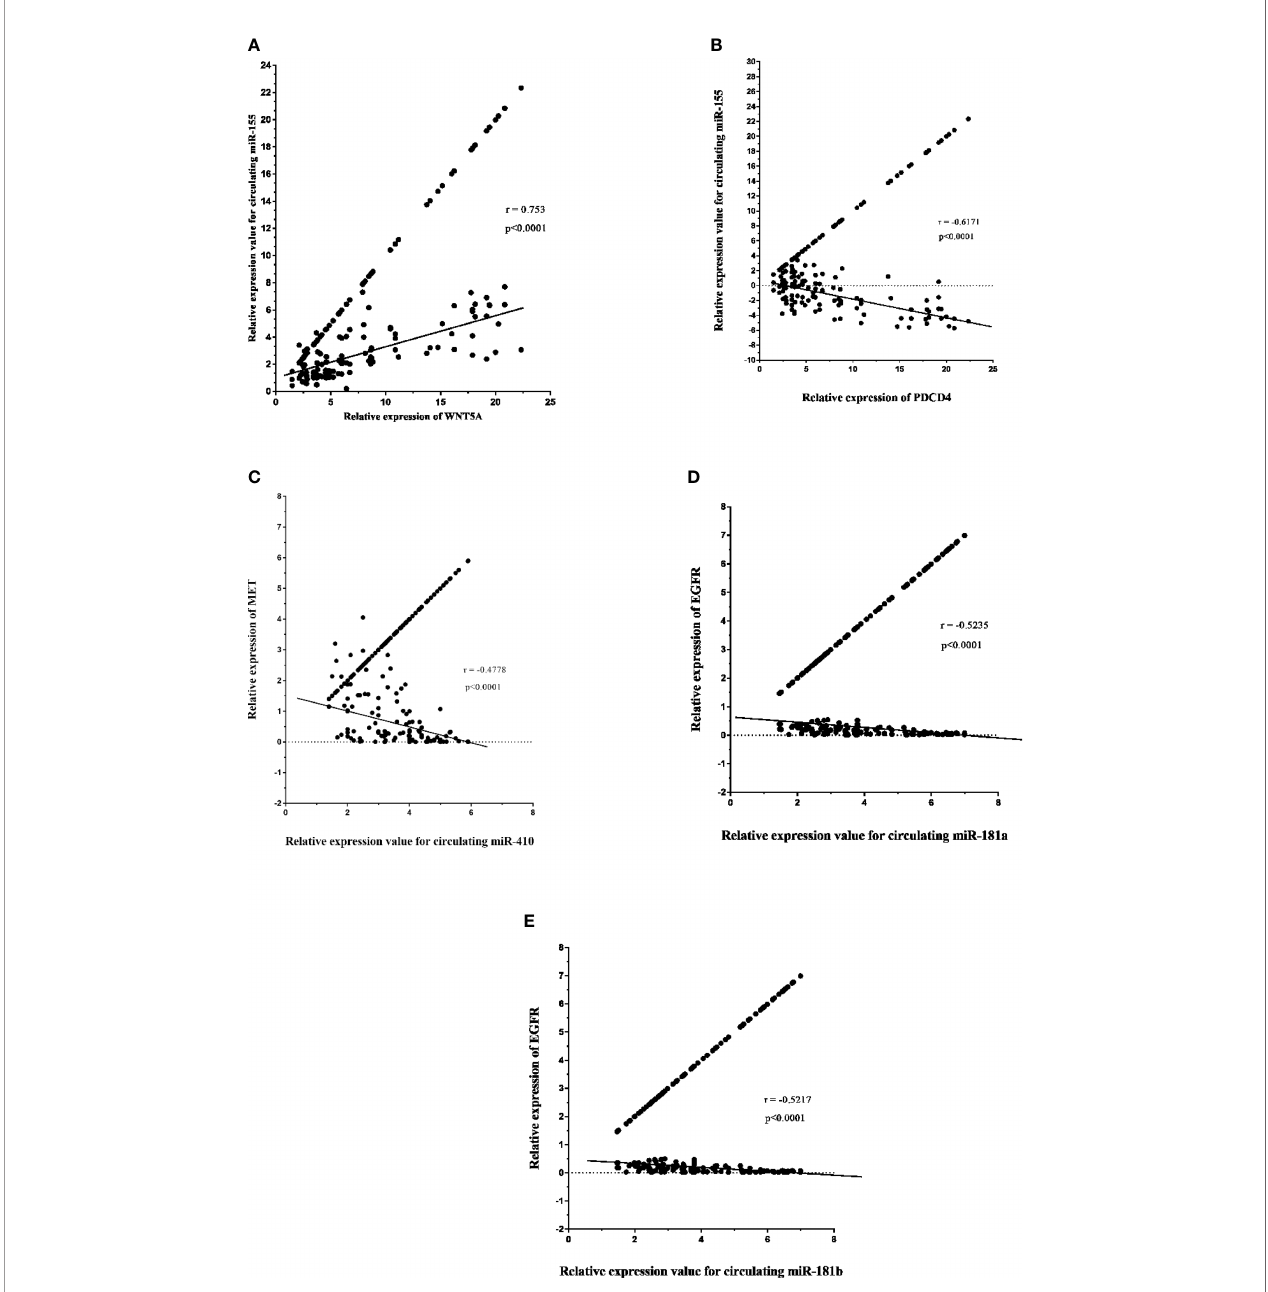
FIGURE 10 | Relative expression of circulating miR-181a/b, miR-410 and miR-155 and its potential gene-targets, programmed cell death 4 (PDCD4), Wnt family member 5A (WNT5A), MET, and epidermal growth factor receptor (EGFR), in plasma samples from high-grade glioma patients (A – E) . (A, B) Correlation between circulating miR-155 expression and PDCD4 and WNT5A levels in plasma samples (p < 0.0001; Spearman rank correlation test: r = 0.753, r = -0.671). (C) Correlation between miR-410 expression and MET levels in in plasma samples (p < 0.0001; Spearman rank correlation test: r = -0.4778). (D, E) Correlation between circulating miR- 181a/b expression and EGFR levels in plasma samples (p < 0.0001; Spearman rank correlation test: r = -0.5235, r =